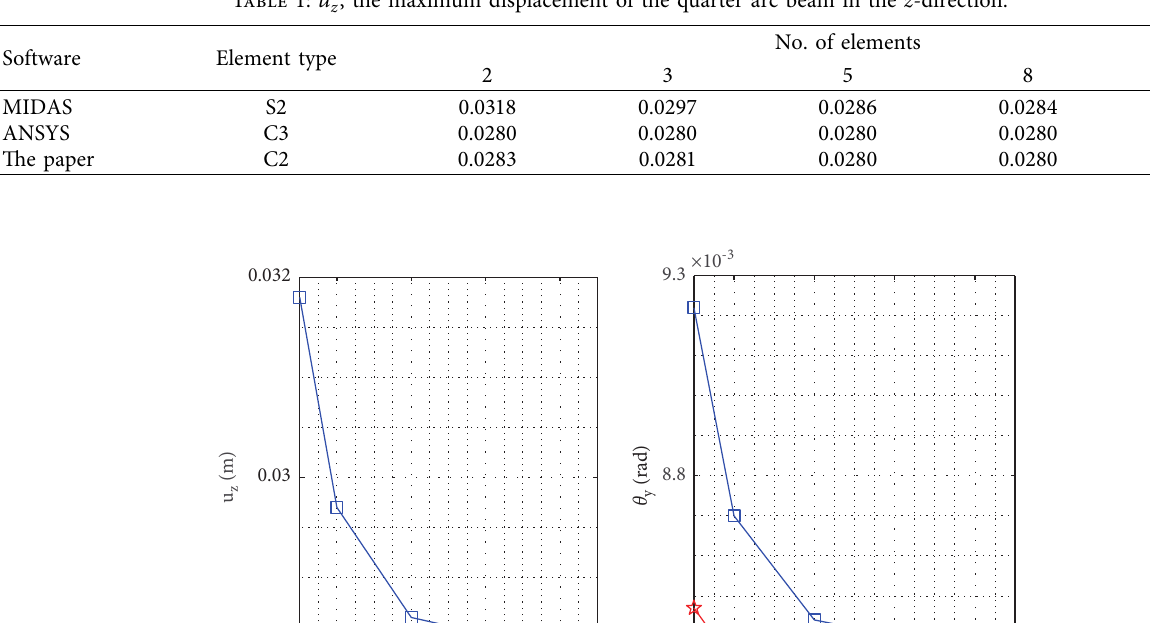
Figure 3: The quarter arc beam model of (a) the circular shape and (b) the elliptical shape. (c, d) Its cross section’s shape is circular, and its corresponding 3D solid finite element model. Table 1: u z , the maximum displacement of the quarter arc beam in the z -direction.